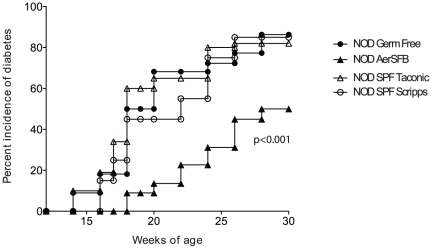
The incidence of type-1 diabetes in female NOD mice remains unchanged under germ-free conditions but is reduced by restricted flora.Cumulative diabetes incidence of germ-free female NOD mice (NOD germ-free n = 22), female NOD mice monocolonized with an aerobic spore-forming bacteria (Bacillus cereus) detected at week 16 (NOD AerSFB n = 22) and female NOD mice housed under specific pathogen-free conditions (NOD SPF Scripps n = 22, NOD SPF Taconic n = 40). Urine glucose was measured every one or two weeks as shown and mice that had reached 4+ (55 mmol/L) were considered diabetic. There was a significant inhibition (p<0.001) in the incidence of diabetes in monocolonized NOD mice compared with SPF NOD mice, but no significant difference between germ free and SPF NOD mice (p>0.05), Anova.